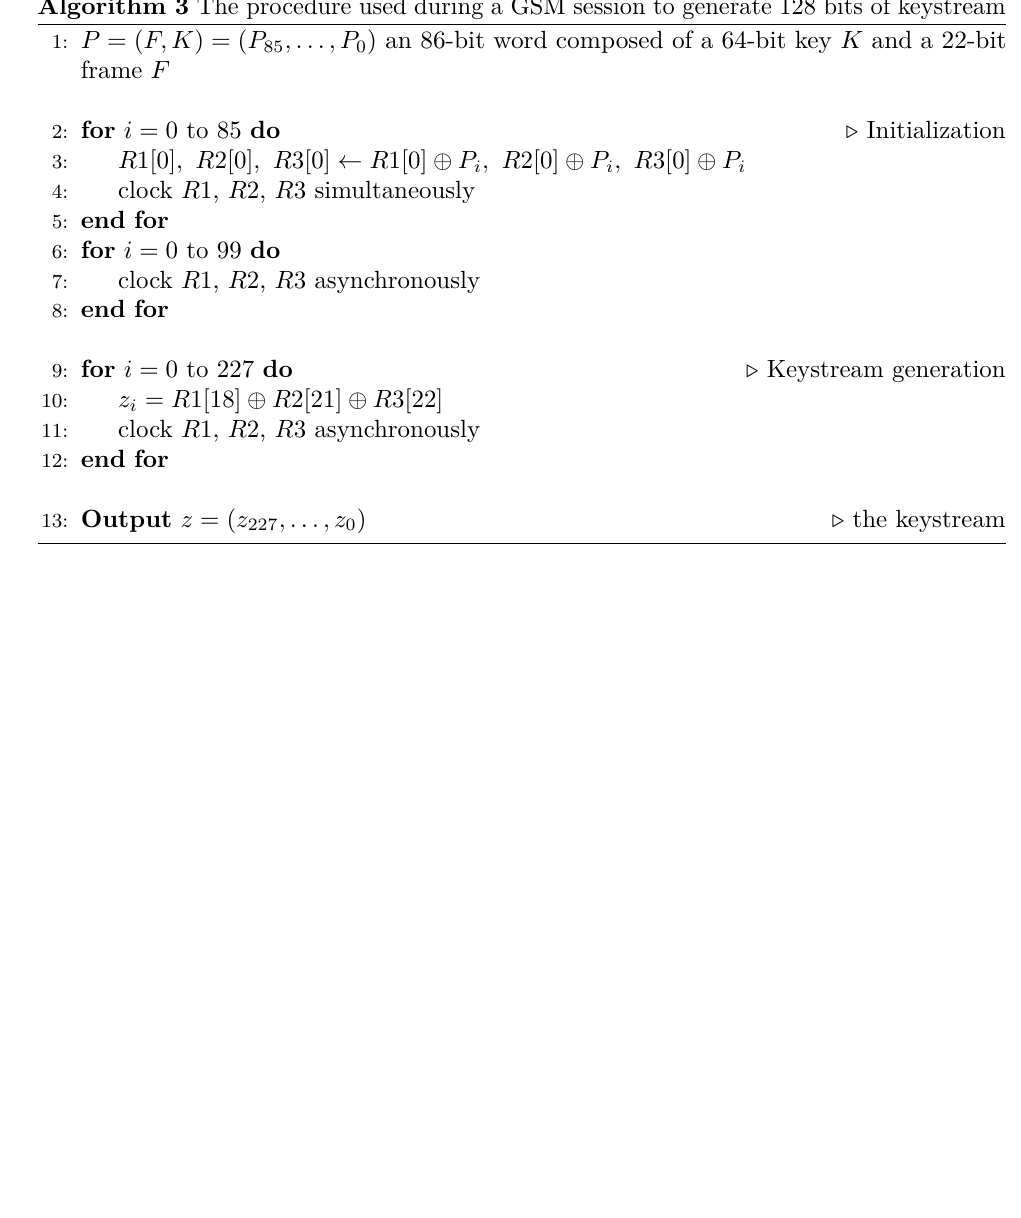
Algorithm 3 The procedure used during a GSM session to generate 128 bits of keystream 1: P = ( F, K ) = ( P 85 , . . . , P 0 ) an 86-bit word composed of a 64-bit key K and a 22-bit frame